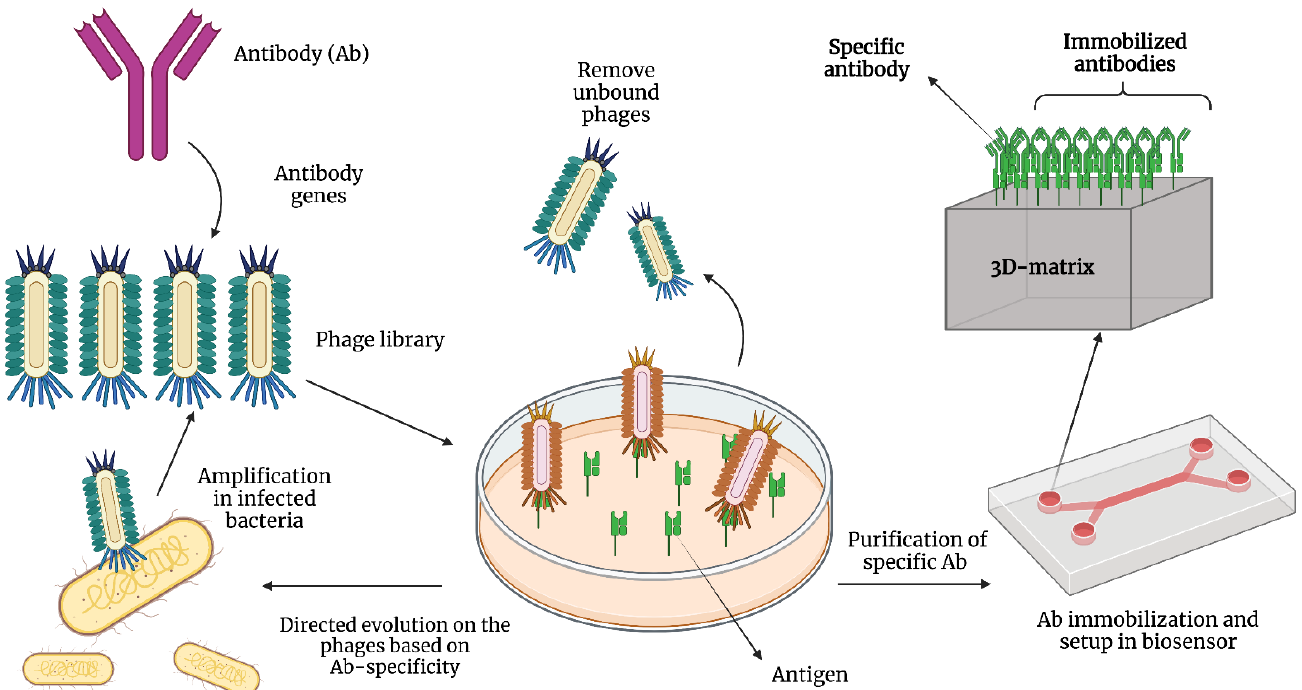
Figure 4. Production of recombinant antibodies using phage display technology. First, a recombinant phage library is created using antibody genes. Next, phages are purified and put in contact with the antigen. Unbound phages are removed. After that, bound phages are eluted and amplified by infecting bacteria. Then, the phages are used to create a new library, and the cycle is repeated until high-affinity antibodies are produced. When that is achieved, the antibodies are purified and immobilized in a biosensor. Table 4. Advantages and disadvantages of recombinant antibodies [27 – 30].